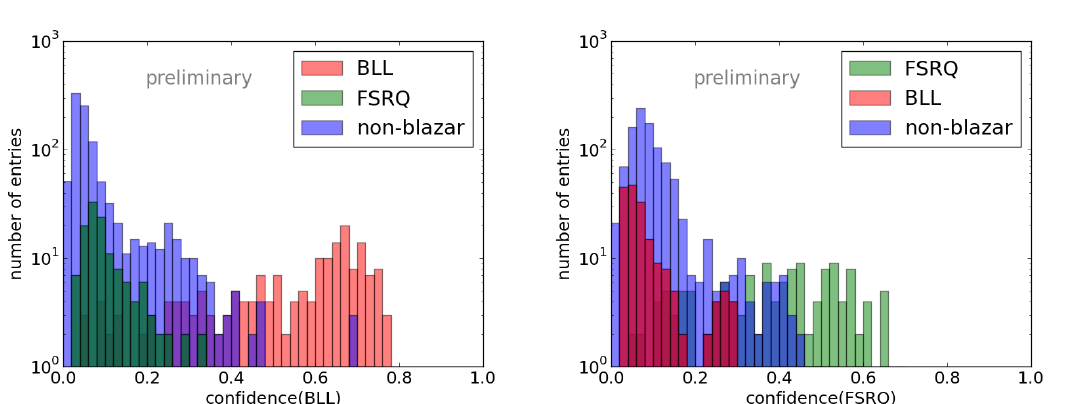
Figure 5. Confidence distribution for the BLL ( left ) and the FSRQ class ( right ). The classification model is applied to the training set extracted from the 3FGL and the 1SXPS catalogs.